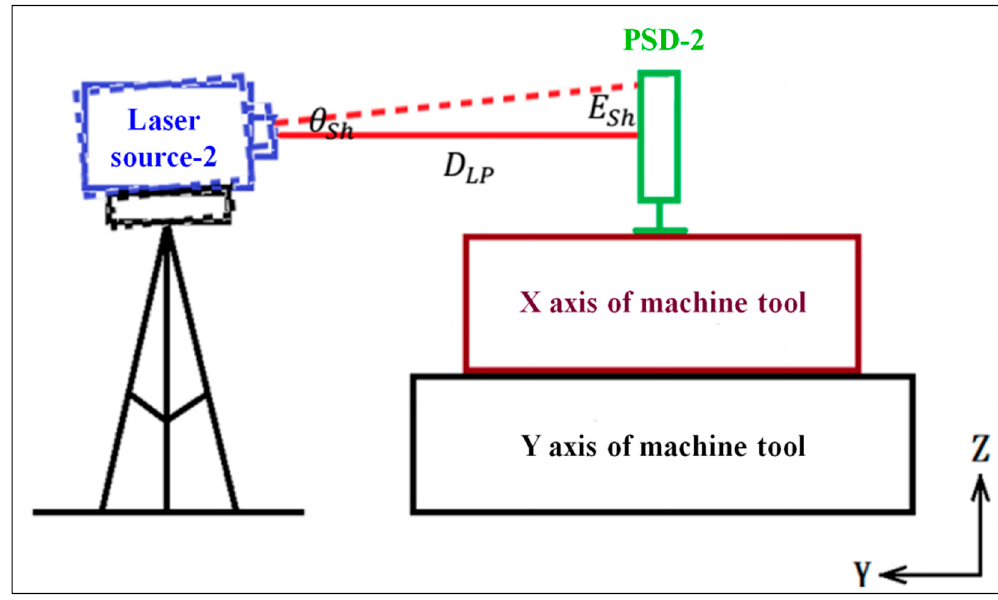
Figure 8. Measurement errors due to laser source vibration.